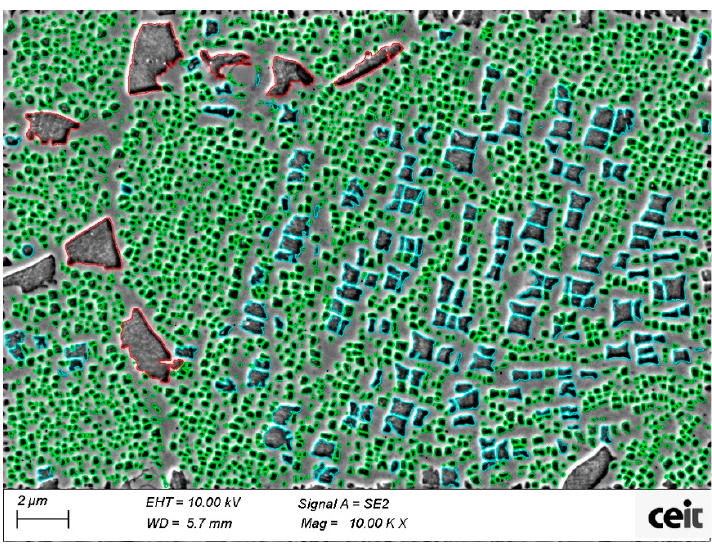
Figure 4. FEG-SEM image of a typical standard HTed Astroloy microstructure taken with the second- ary electron detector. γ′ are coloured with red for primary γ′ , blue for secondary γ′ and green for secondary electron detector. γ (cid:48) are coloured with red for primary γ (cid:48) , blue for secondary γ (cid:48) and green tertiary γ′ . for tertiary γ (cid:48)